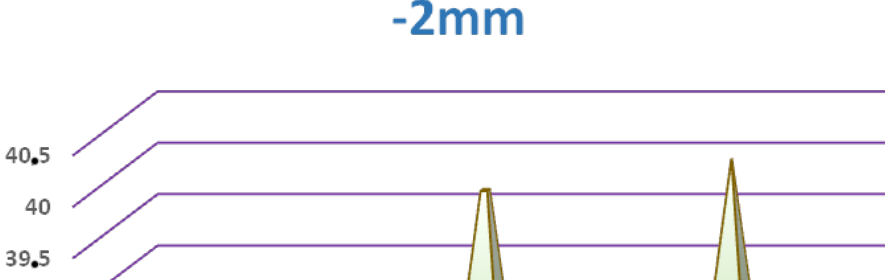
Figure 4. Average temperatures at − 2 mm and − 4 mm with Calamus ® ( p = 0.002). If the different systems were compared according to the sealing depth, no statistically significant differences were found between the different systems at − 2 mm ( p = 0.197) (Figure 5) or − 4 mm ( p = 0.620) (Figure 6).